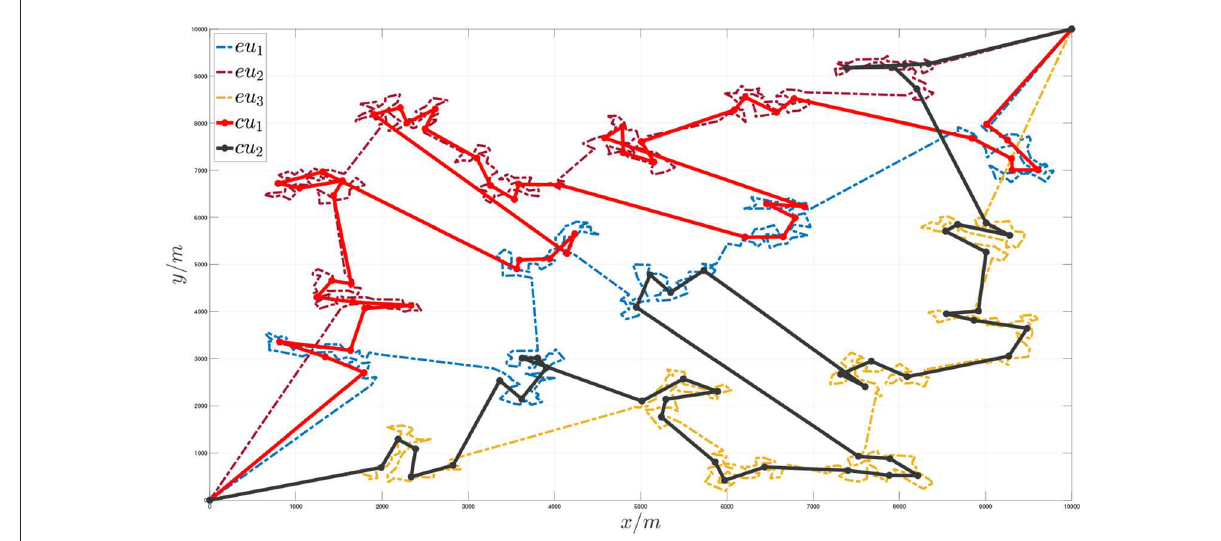
FIGURE9 Schematic diagram of the communication unit and the execution unit cooperating to access the target task